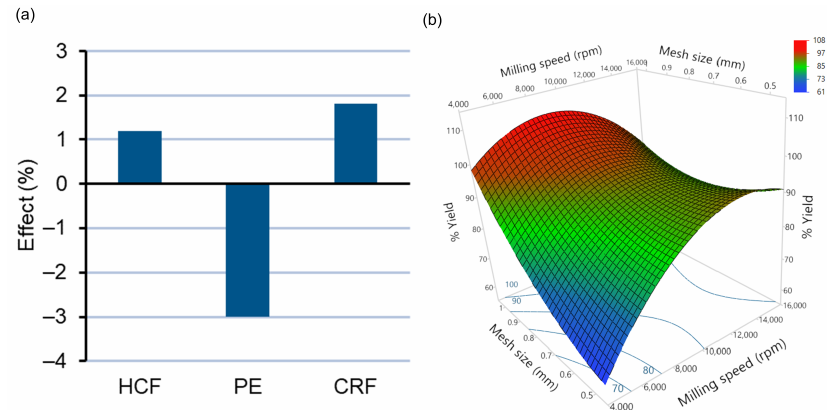
Figure 4. ( a ) Plot depicting the effect of type of feedstock on percentage yield. ( b ) Response surface plot depicting the effects of milling speed and mesh size on percentage